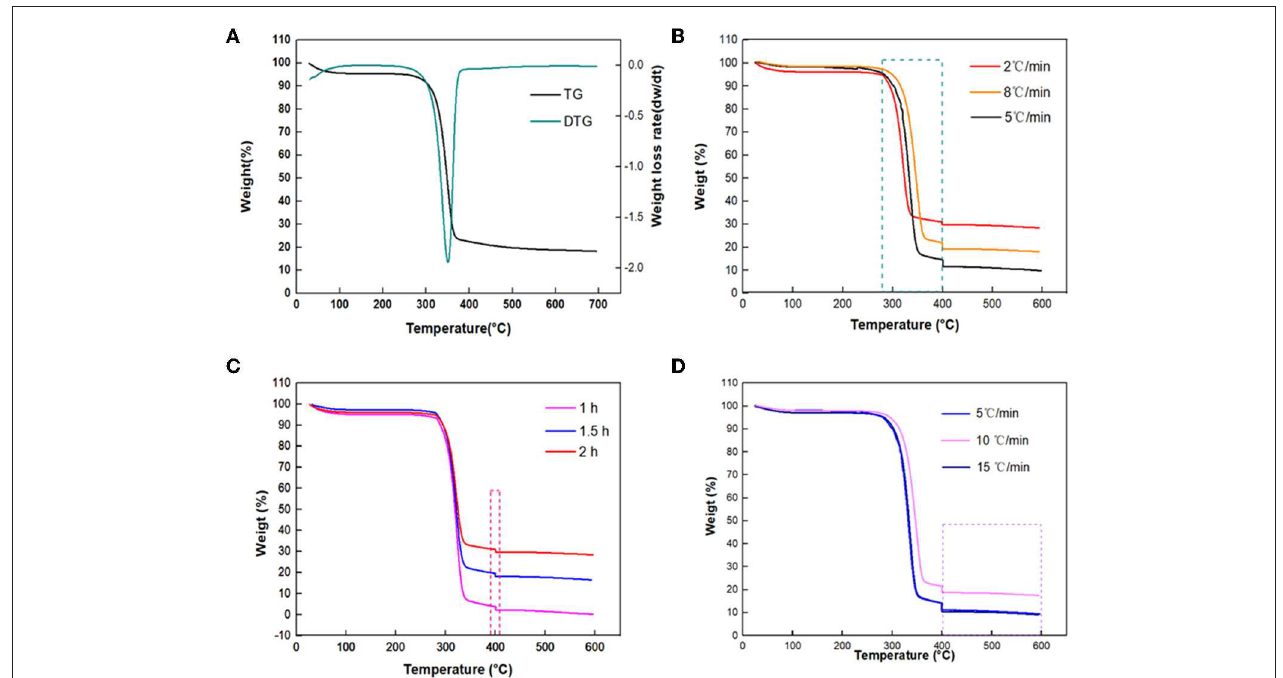
FIGURE 2 | TG and DTG curves of sisal hemp pulp-based paper (A) ; TG curves at 280–400 ◦ C at different heating rates (8, 5, and 2 ◦ C/min) (B) ; at 400 ◦ C with different holding times (1, 1.5, and 2h) (C) ; and at 400–600 ◦ C at different heating rates (5, 10, and 15 ◦ C/min) (D) .